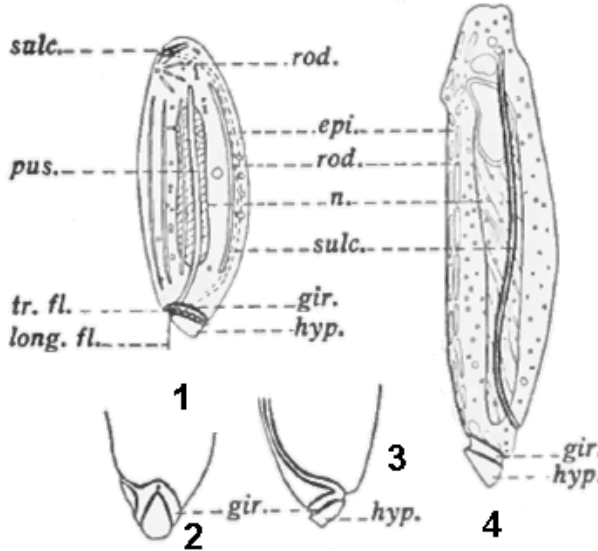
Figures 1-4. Torodinium Torodinium robustum species diagram taken from Kofoid and Swezy (1921). (1) . Left lateral view. (2) Ventral view of Torodinium teredo antapical region. (3) Right lateral view of antapical region of the same figure. (4) . Abbreviations: epi., epicone; (gir., girdle or cingulum; hyp., hypocone; long fl., longitudinal flagellum; n., nucleus; pus., pusule; rod., rodlets or rhabdosomes; sulc., sulcus; tr. fl., transverse